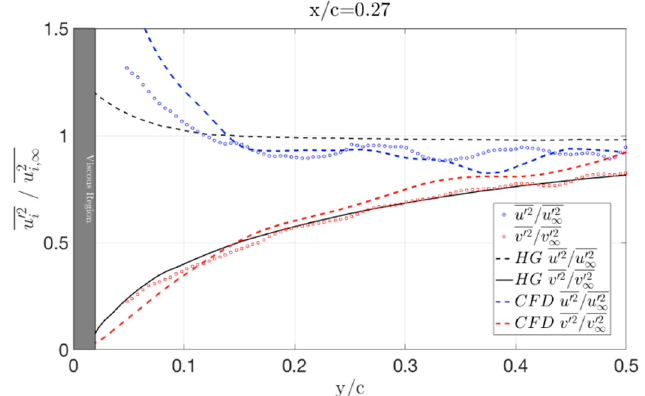
Figure 25. Experimental (dots) and numerical (dashed lines) profiles of the streamwise and transverse Reynolds stress components at x / c = 0.27. Note HG is theory from Hunt and Graham [34].